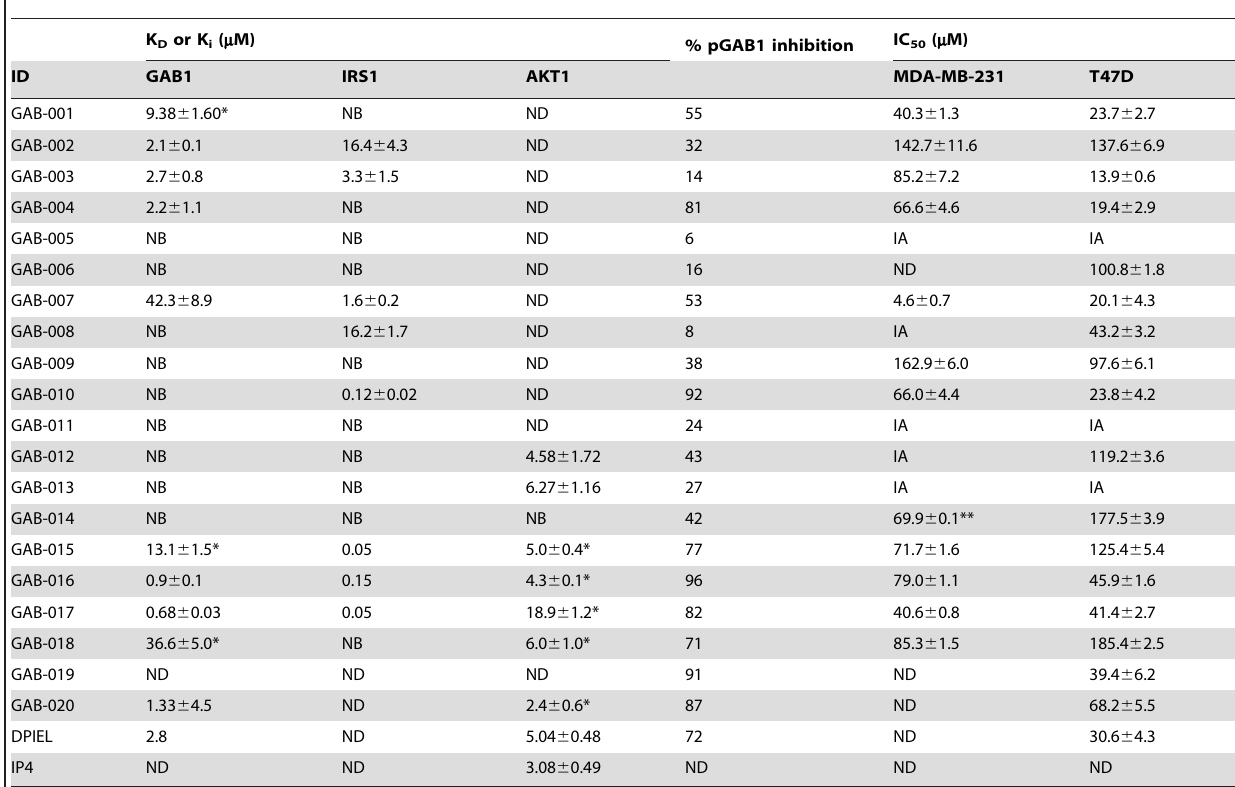
Table 1. Biochemical and biological activities of